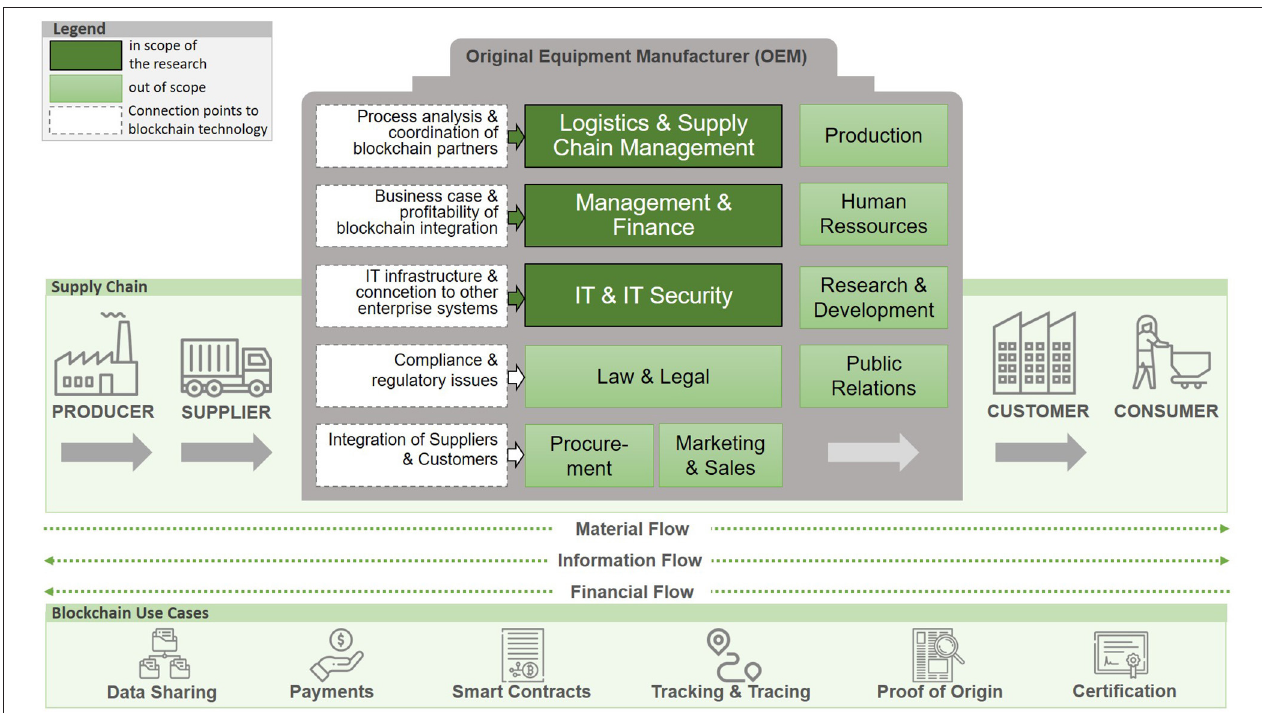
FIGURE 1 | Enterprise functions involved in a blockchain-based supply chain. Own Graphic. Inspired by Lambert et al. (1998), Jakob et al. (2018), Schulte and Dorn (2018) and Gürpinar et al.